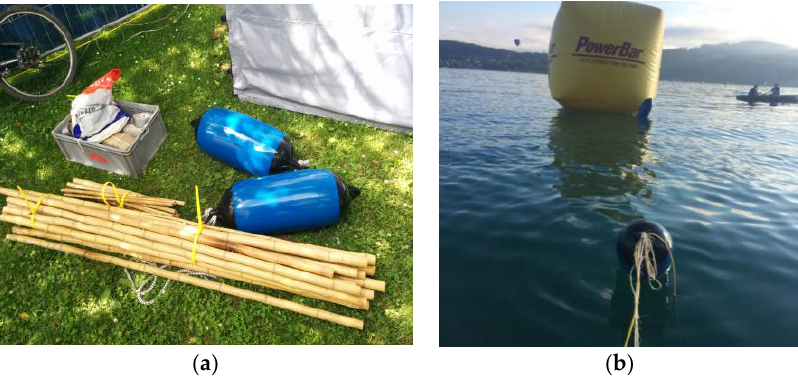
Figure 5. ( a ) Components of the underwater timing antenna; ( b ) Operation in the lake, view from the timing boat, in the background the yellow turning buoy, in the foreground the fender buoy.